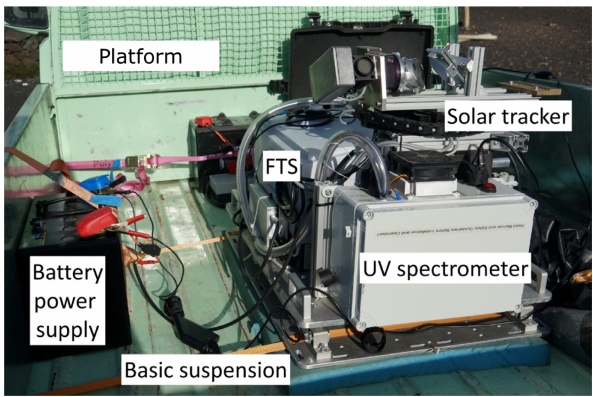
Figure 1. Photograph of the remote sensing observatory on the mo- bile platform, a small truck. The observatory consists of the Fourier transform spectrometer (FTS) EM27/SUN and the UV spectrom- eter ULS2048x64-ENV5. A common solar tracker feeds sunlight into the two spectrometers. The observatory sits on a rubber and foam suspension. A 12V battery supplies power to the spectrome- ters, the solar tracker, two control laptops for the spectrometers, and a low-power consumption PC for the solar